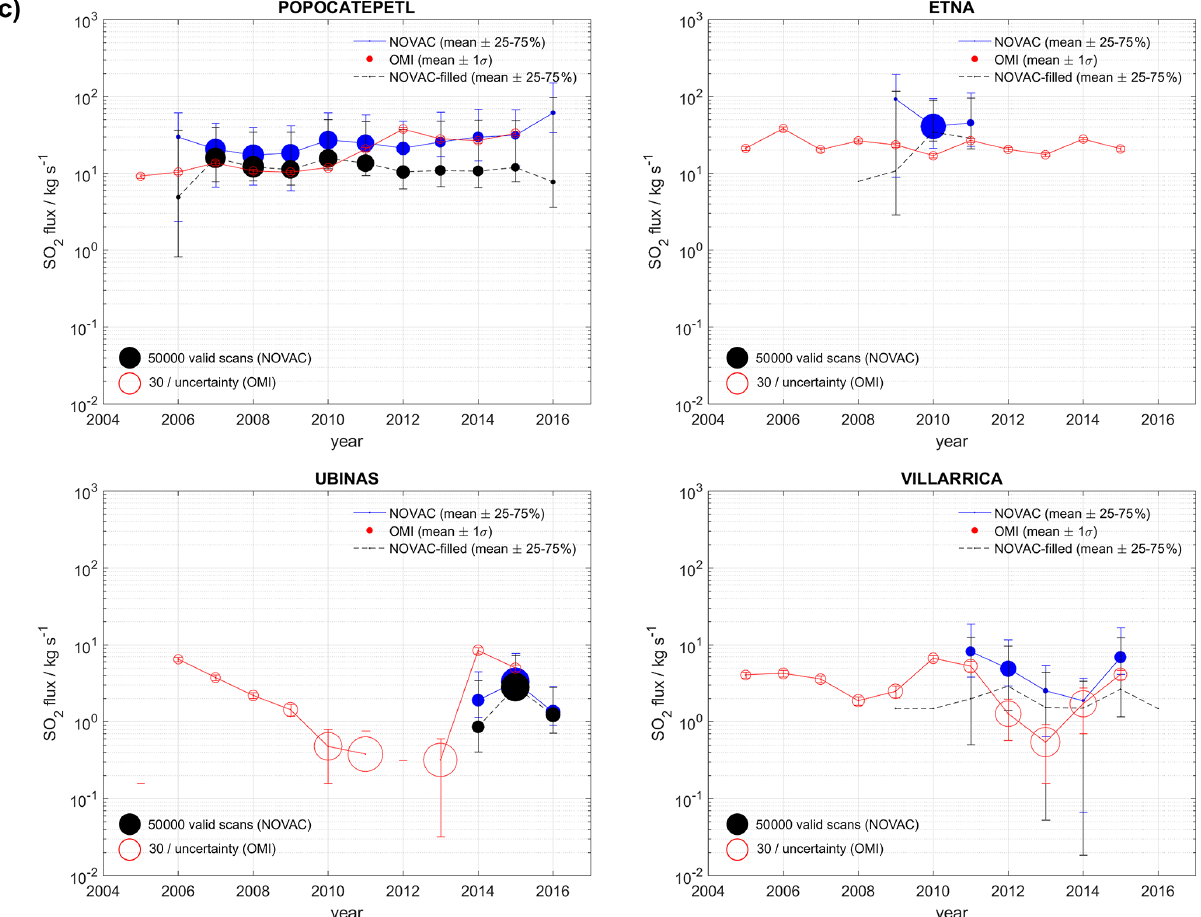
Figure 5. Time series of annual SO 2 emission from 12 volcanoes in NOVAC for which corresponding results from OMI are available for the period 2005–2016. Dots show the annual mean emission rate with size linearly proportional to the number of valid measurements used for the average. The bars indicate the 25% and 75% quantiles of the daily means for each year. The series shown in blue correspond to observed plumes, while in black is the emission adjusted for periods of low degassing, when no plumes were observed (see text for details). The series in red is the mean annual emission rate obtained from OMI measurements, with the size proportional to the precision (reciprocal of uncertainty) of the estimation and bars showing ± 1 standard deviation as reported by Carn et al. (2017). (a) Data from Copahue, Etna, Galeras, and Isluga. (b) Data from Masaya, Mayon, Nevado del Ruiz, and Nyiragongo. (c) Data from Popocatépetl, Tungurahua, Ubinas, and Villarrica. For details of the data in numerical format see Supplement